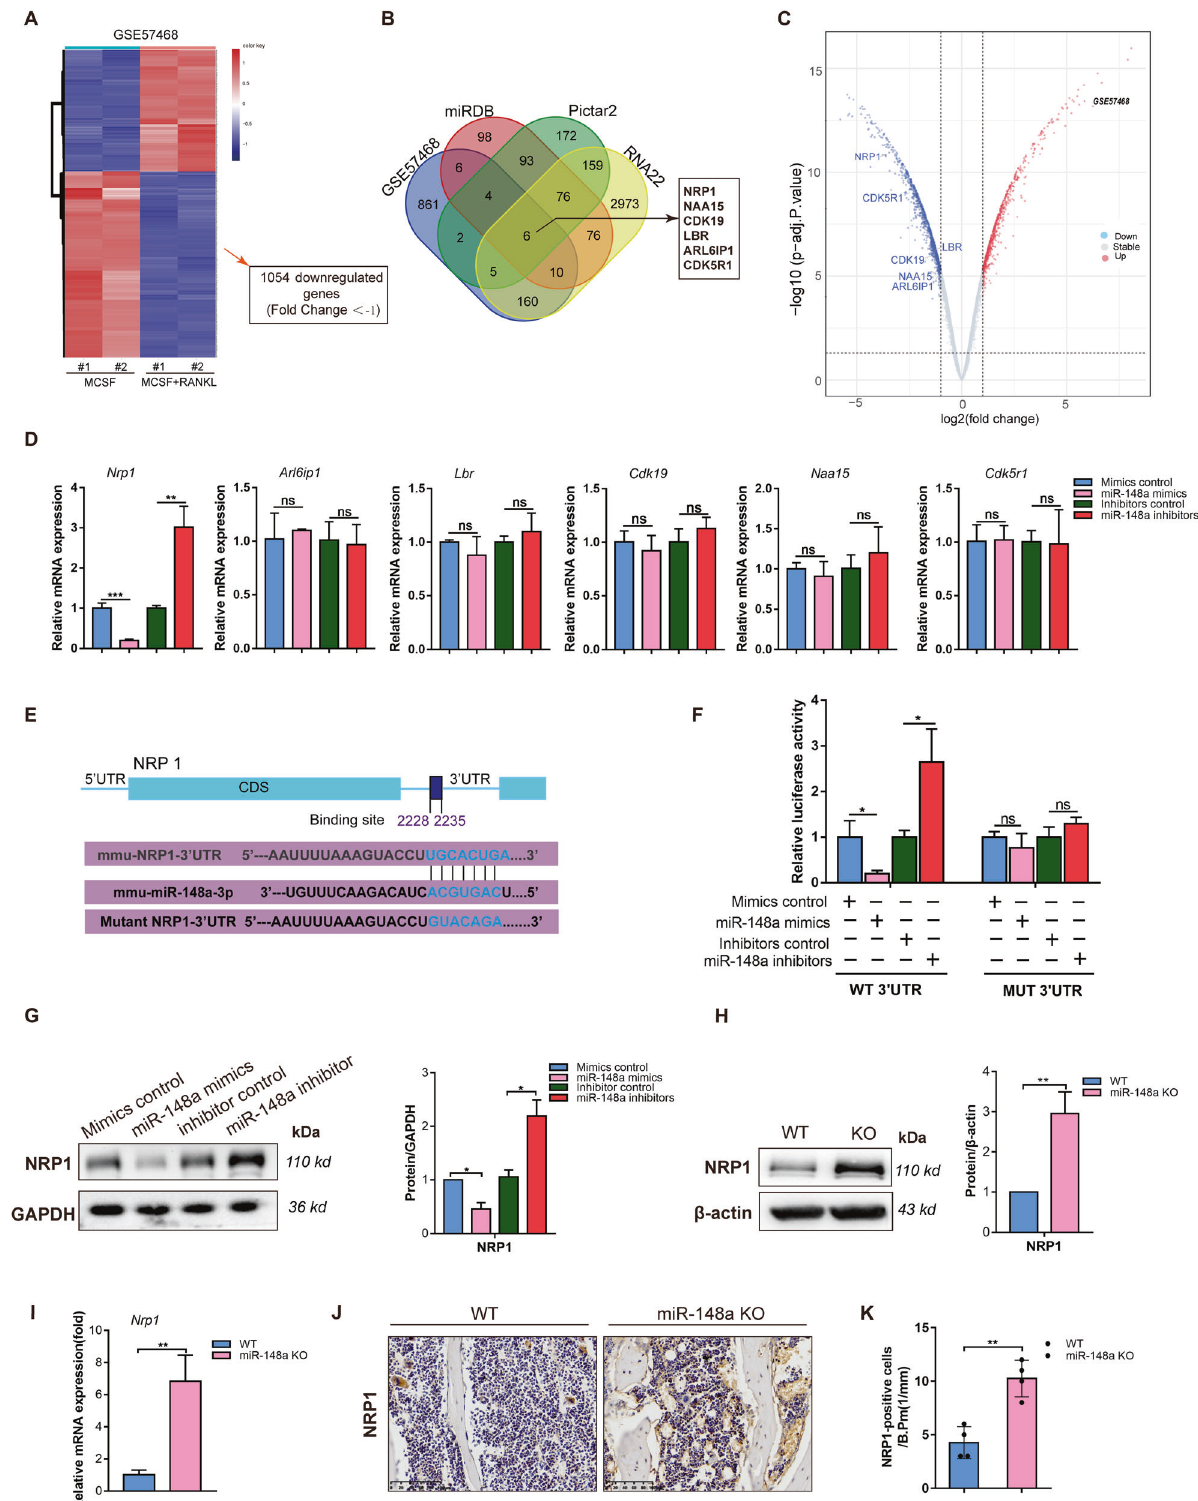
NRP1 protein levels were reduced after miR-148a overexpression in BMMs (Fig. 4G). As expected, the expression of NRP1 was markedly increased in miR-148a-de fi cient osteoclasts (Fig. 4H, I). Additionally, this effect was further supported by IHC staining, miR-148a deletion caused an increase in the expression of NRP1